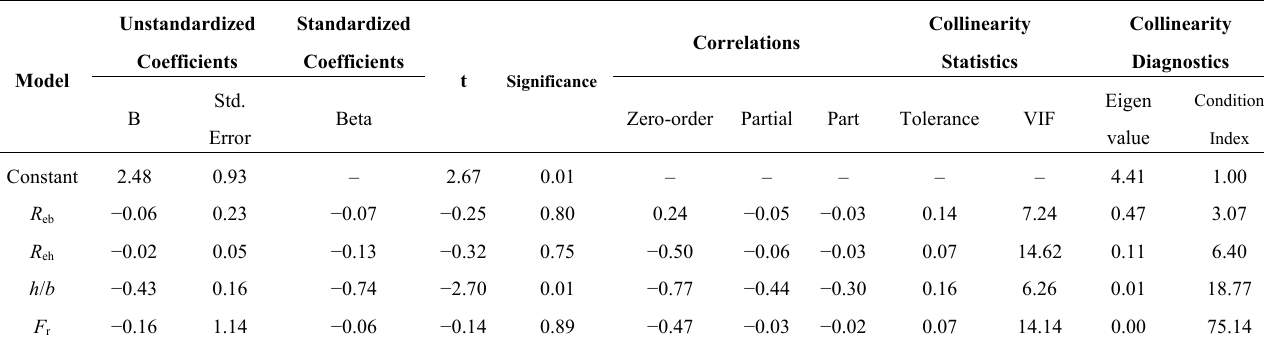
Table 4. Linear regression